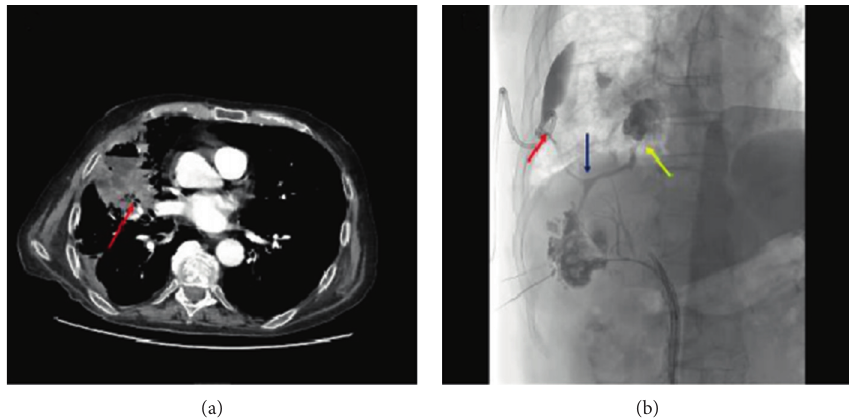
Figure 4: Chest-abdomen CT scan showing a 50mm-diameter abscess of the middle lobe communicating with the subsegmental bronchi (arrow) (a); percutaneous cholangiography revealing a “Y”-shaped fistula originating from intrahepatic bilioma (blue arrow) and divided in two arms which reached separately the pleural space (red arrow) and the middle lobe abscess up to one segmental bronchus (yellow arrow)